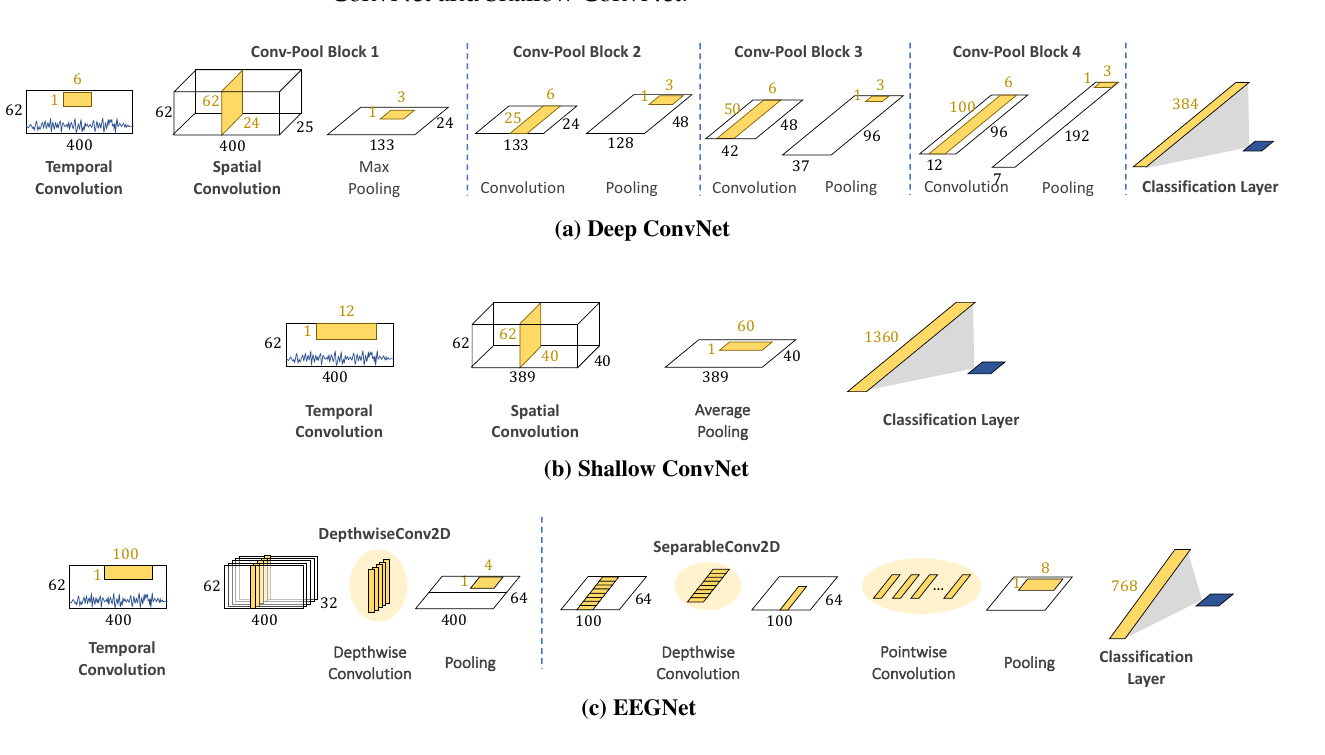
Figure 3. Model architectures of ( a – c